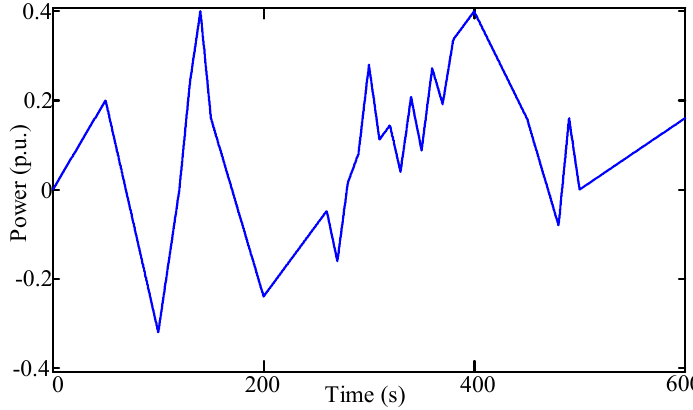
Figure 12. Ten-minutes wind variation profiles.